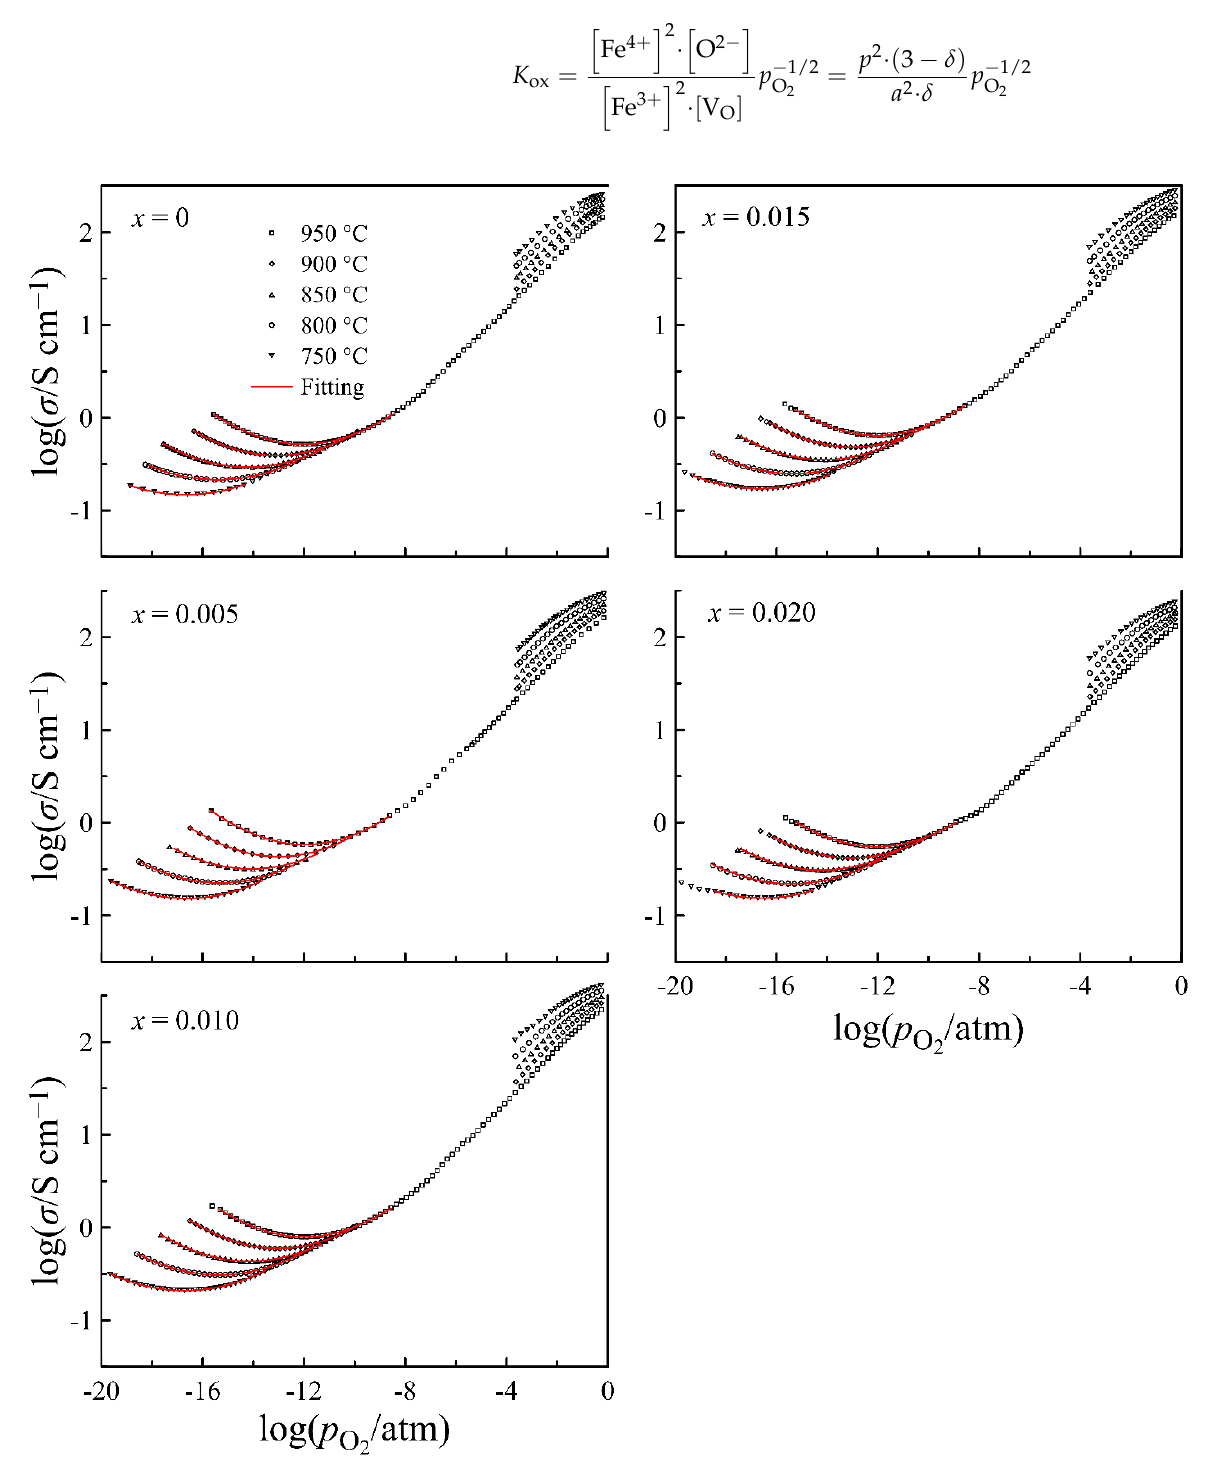
Figure 7. Electrical conductivity of dense La 0.5 − x Sr 0.5 FeO 3 − δ ceramics ( ≥ 90%) as a function of oxygen partial pressure at different temperatures. Solid lines represent the results of Equation (1) approximation to the experimental data.